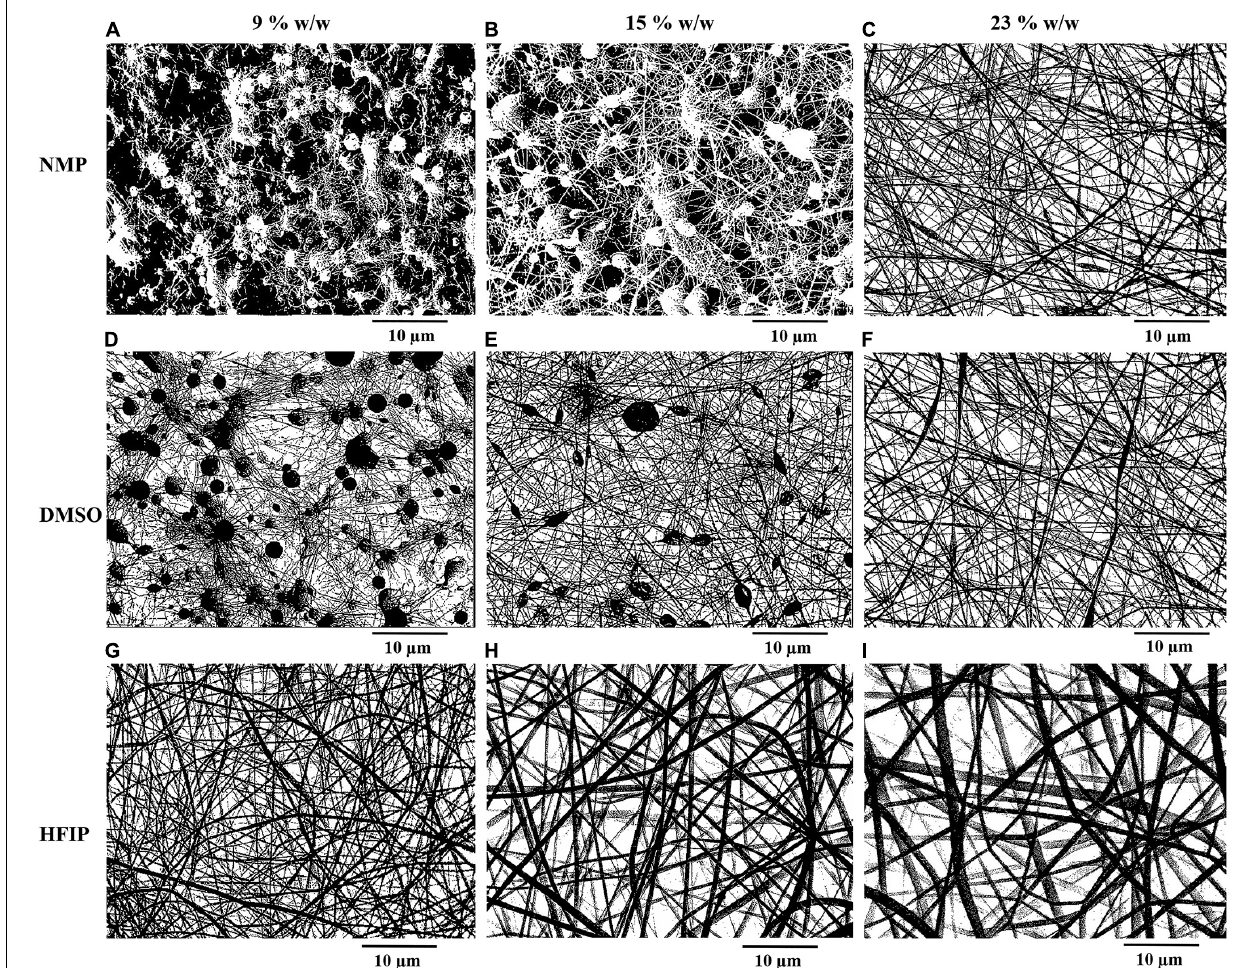
FIGURE 5 | Binary images of electrospun PPC nanofibers prepared with NMP (A–C) , DMSO (D–F) , and HFIP (G–I) in different concentrations of PES [9% w/w (A,D,G) , 15% w/w (B,E,H) , 23% w/w (C,F,I) ], (PANI concentration: 0.5%